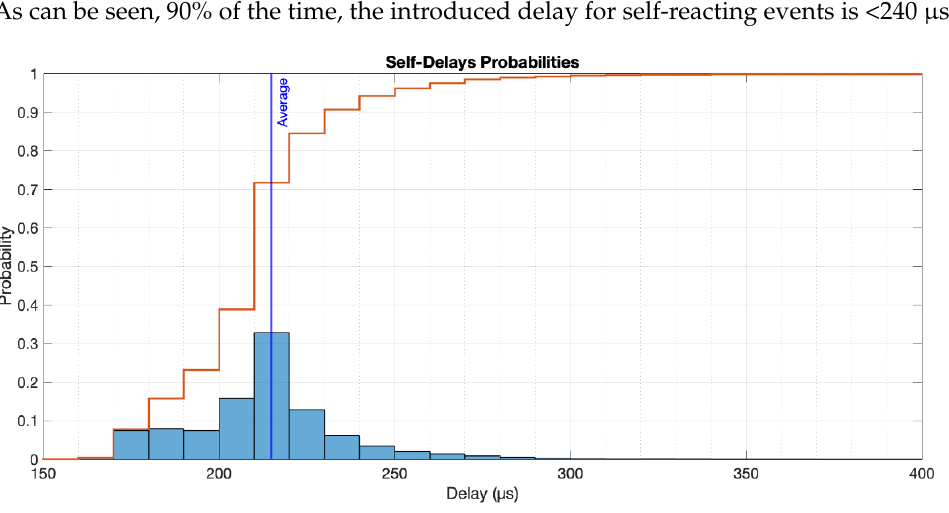
Figure 6. Self-delays probabilities.